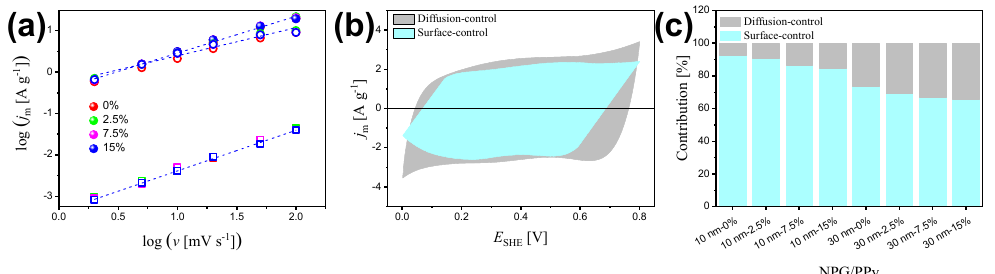
Figure 5. ( a ) Linear fitting of the logarithm of peak current density, log( j m ), as a function of loga- rithm of scan rates, log( v ), for bare NPG, NPG/PPy(10 nm), and NPG/PPy(30 nm) under various deformations. Open square, closed symbol, and open circle represent NPG, NPG/PPy(10 nm), and NPG/PPy(30 nm), respectively. The color conventions indicate the deformation. ( b ) Voltammet- ric response of non-deformed NPG/PPy(10 nm)at a scan rate of 10 mV s − 1 . The contributions from surface-controlled and diffusion-controlled processes are determined from Equation (4). ( c ) Capaci- tance contribution at v = 10 mV s − 1 for NPG/PPy specimens under different